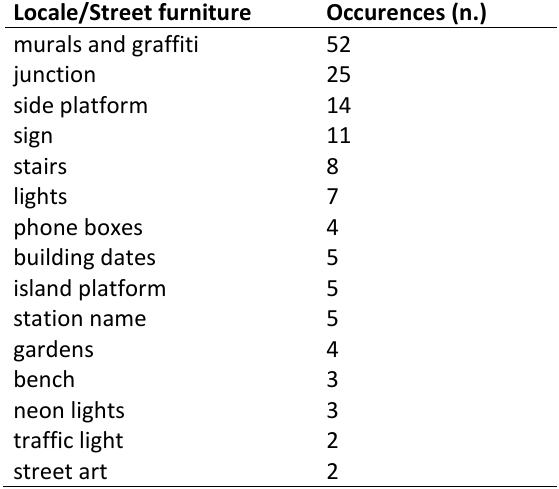
Table 5. Most recurring terms in the “activities” category. Food